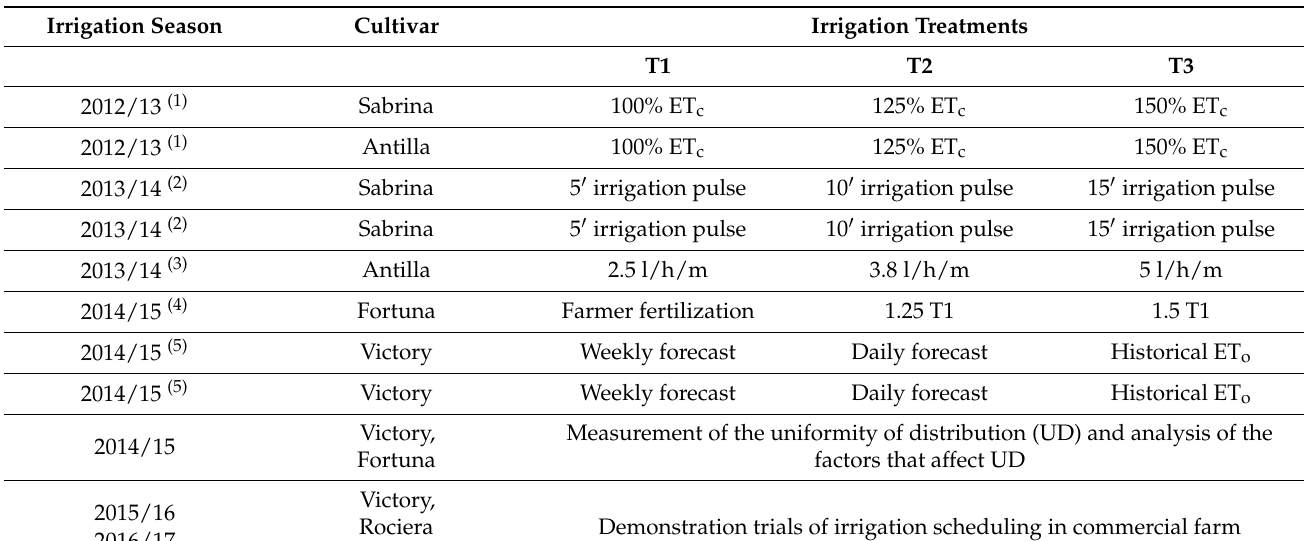
Table 1. Trials and irrigation demonstration carried out by IFAPA in Almonte, Lepe and Rociana del Condado fields (Huelva) between the 2012 and 2017.